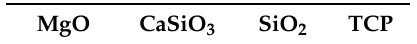
Table 1. Composition (wt %) of the starting